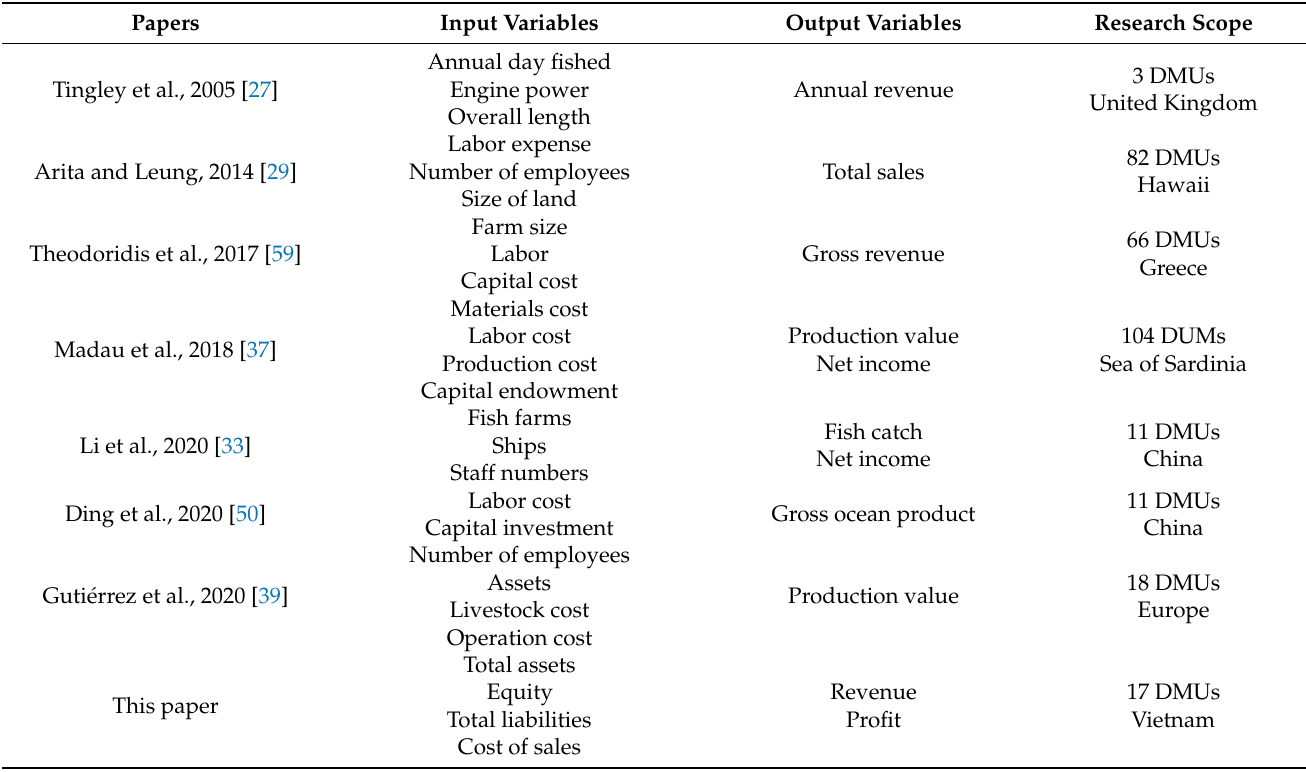
Table 3. List of input and output variables used in related previous